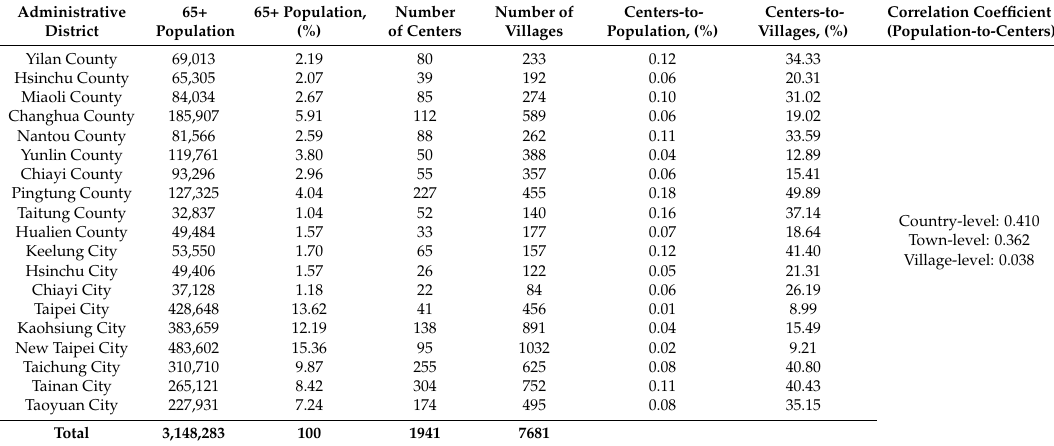
Table 2. Summarystatisticsof65+populationandcommunitycarecentersmeasuresbyadministrativedistrict.